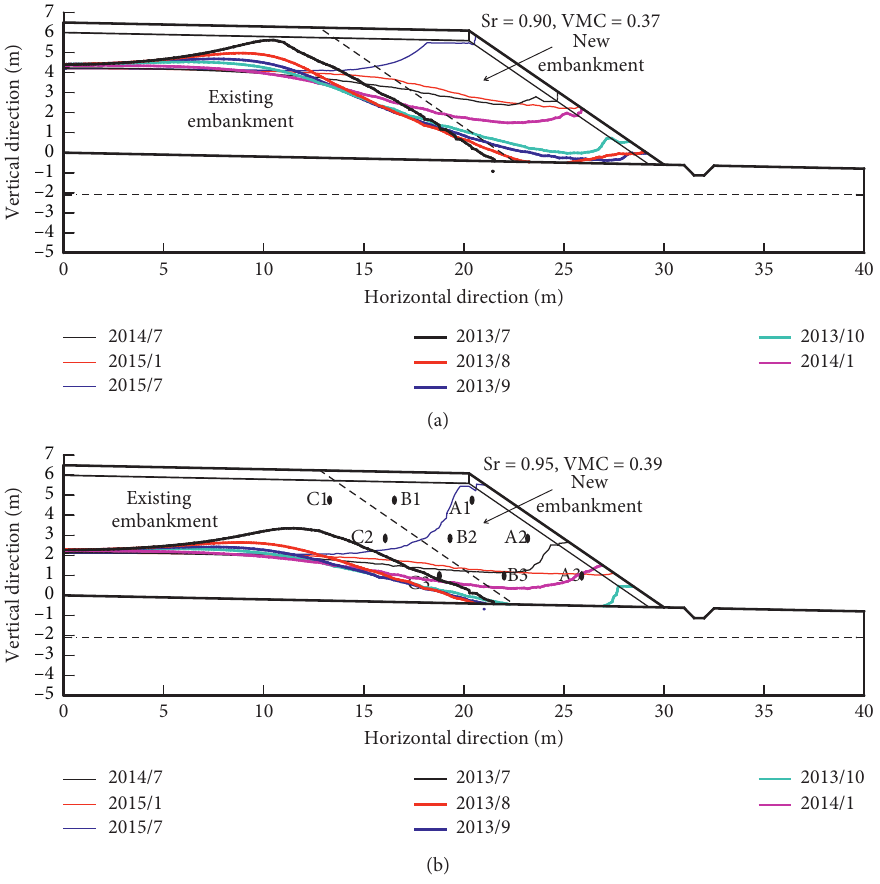
Figure 8: Volumetric moisture content contour over time: (a) VMC � 0.37 and (b) VMC �